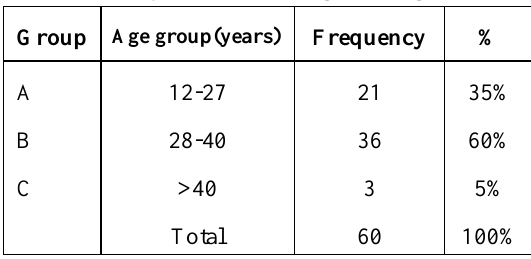
Table 2. Frequency of cutaneous leishmaniasis in the examined patients according to the age.